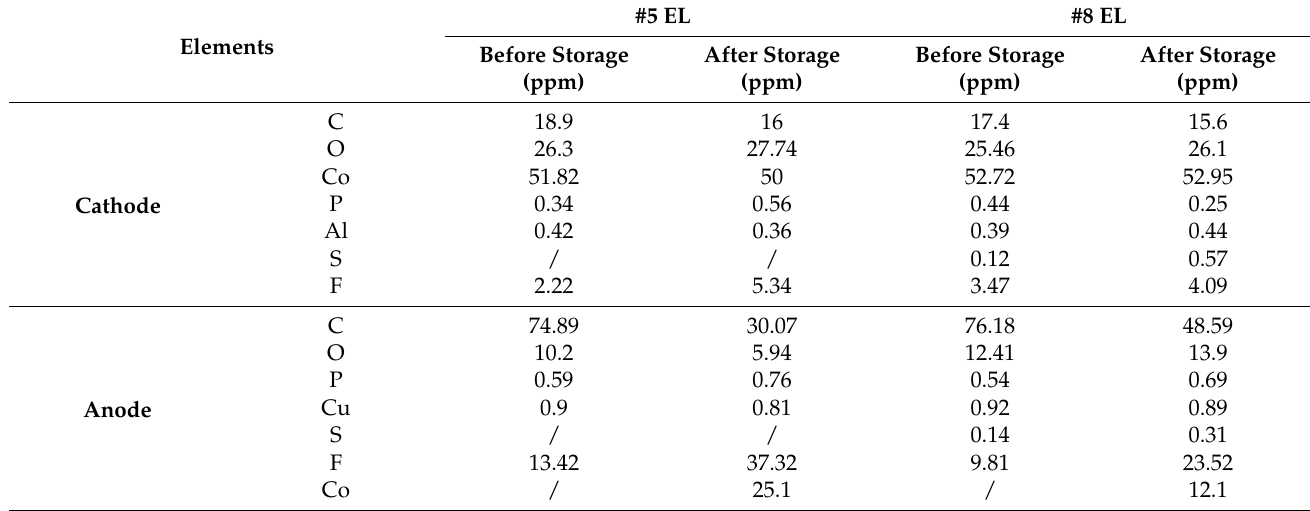
Elements Before Storage After Storage